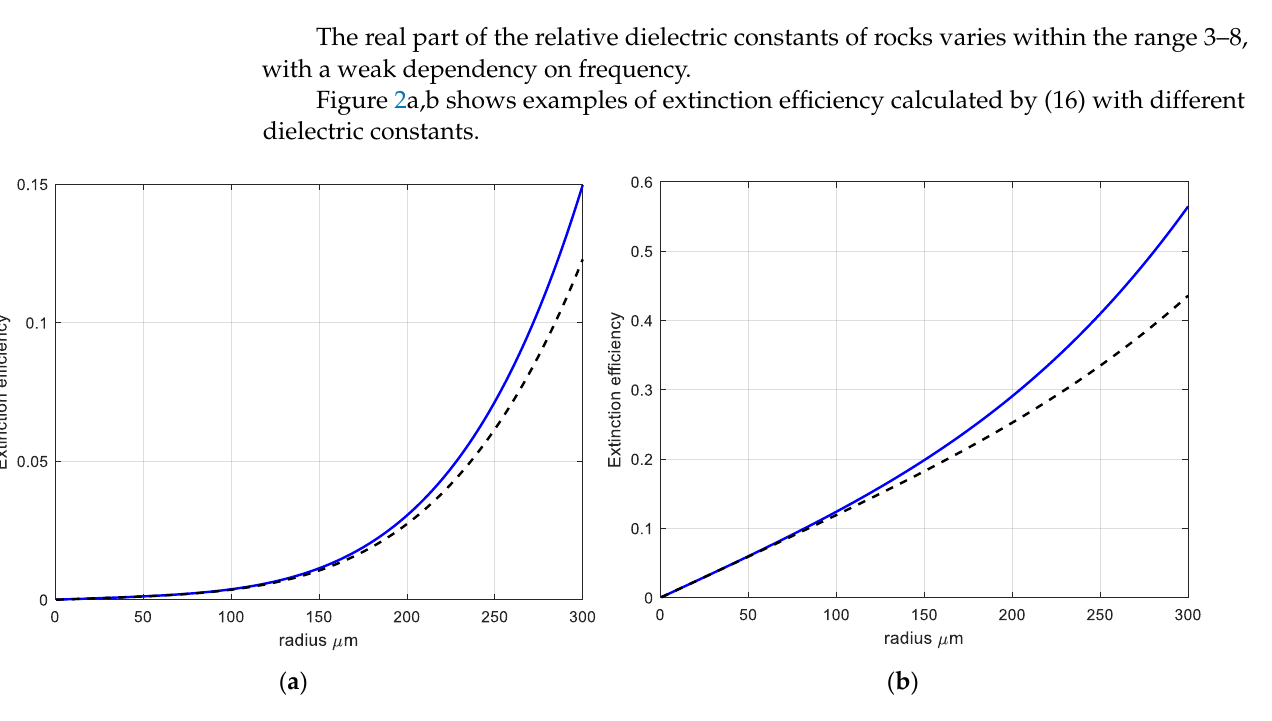
Figure 2. Extinction efficiency Q ext = C ext/ π r 2 for 94 GHz and Brownout Desert particles with dielectric constant: ( a ) ε = 5.5 − j 5.15 × 10 −2 ; ( b ) ε = 3.5 − j 1.65. The solid line ( ― ) — Mie solution; dashed line ( ‒ constant: ( a ) ε = 5.5 − j5.15 × 10 − 2 ; ( b ) ε = 3.5 − j1.65. The solid line ( — )—Mie solution; dashed line ‒ ) — Rayleigh approximation (16). ( — — )—Rayleigh approximation